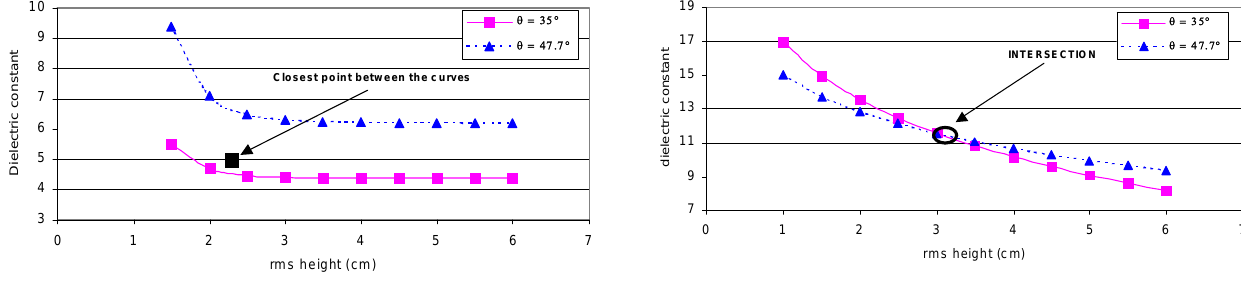
Fig. 9. Variation of the dielectric constant as a function of rms height for two different.